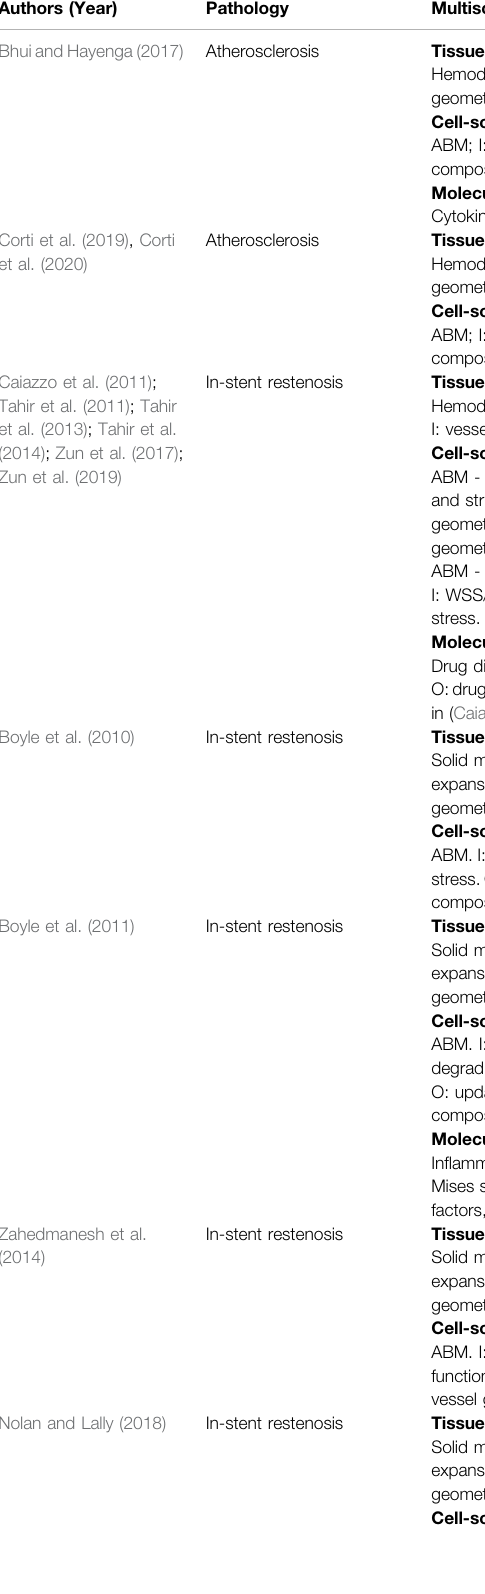
TABLE 1 | Multiscale agent-based modelling frameworks of vascular adaptation. Authors